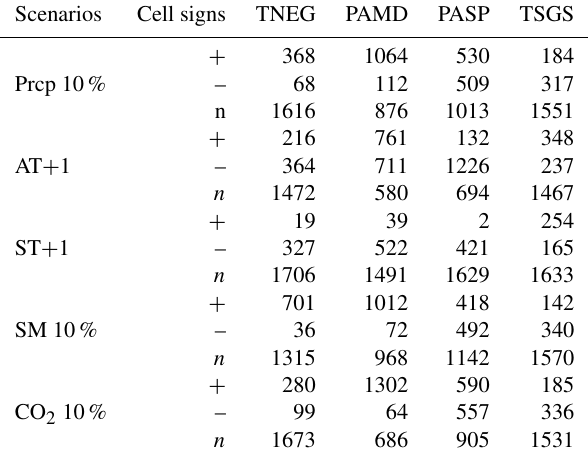
Table 5. Numbers of the cells that display positive ( + ) , negative (–) and non or negligible ( n ) elasticity for the four major plant func- tional types with precipitation increased by 10% (Prcp 10%), air temperature increased by 1 ◦ C (AT + 1), top layer soil temperature increased by 1 ◦ C (ST + 1), top layer soil moisture increased by 10% (SM 10%), and CO 2 concentrations increased by 10% (CO 2 10%). There are 2052 grid cells in total. TNEG: temperate needleleaf ev- ergreen trees, PAMD: perennial alpine meadow, PASP: perennial alpine steppe, TSGS: temperate summergreen scrub/grassland.